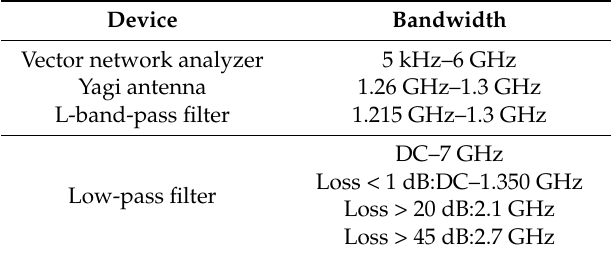
Table 1. Bandwidth of devices.